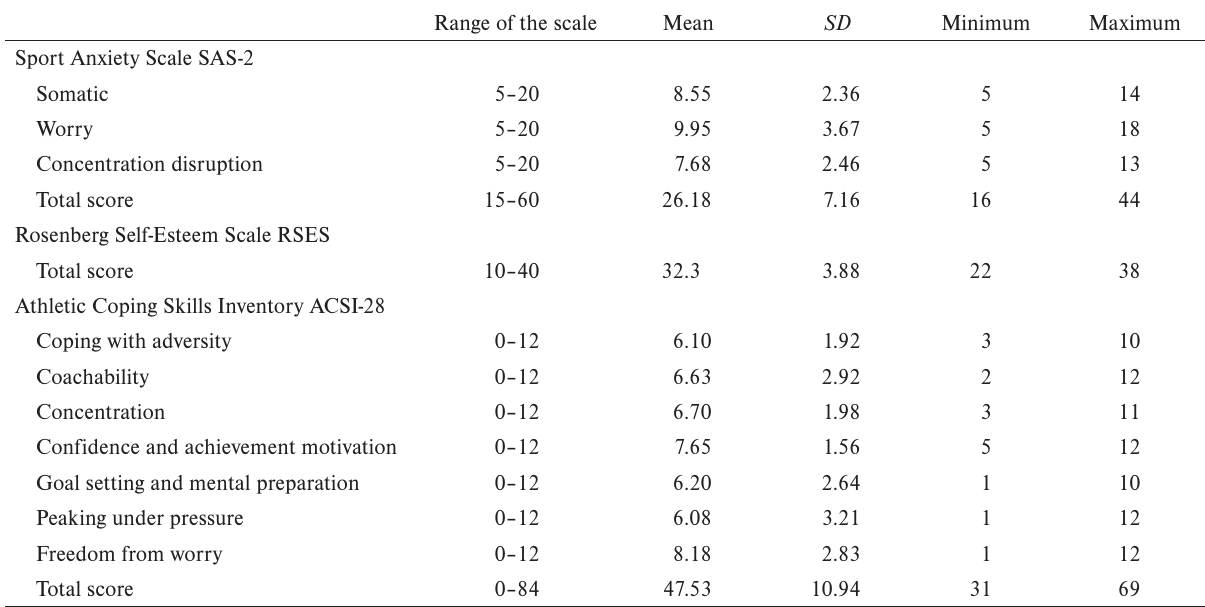
Descriptive statistics of ice hockey